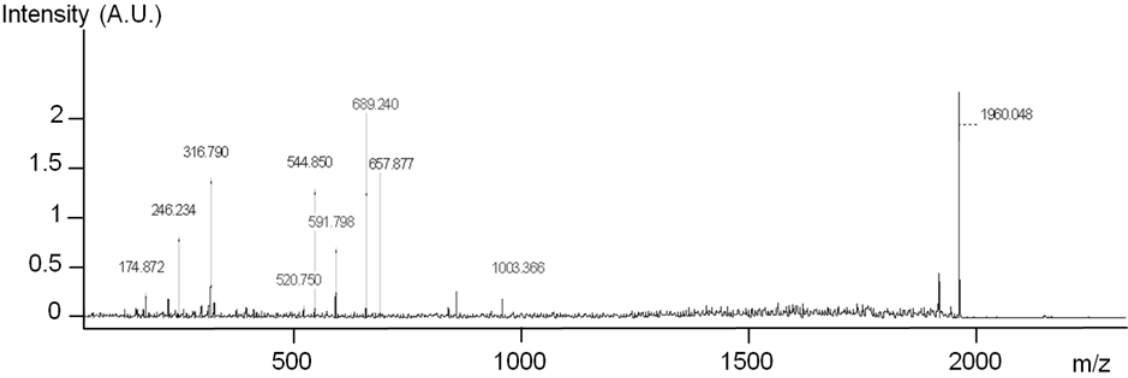
Figure 9. MS 2 analysis of the 1960 Da peak on GaAs (100) functionalized with 10% MHDA after Rat Serum Albumin (RSA)